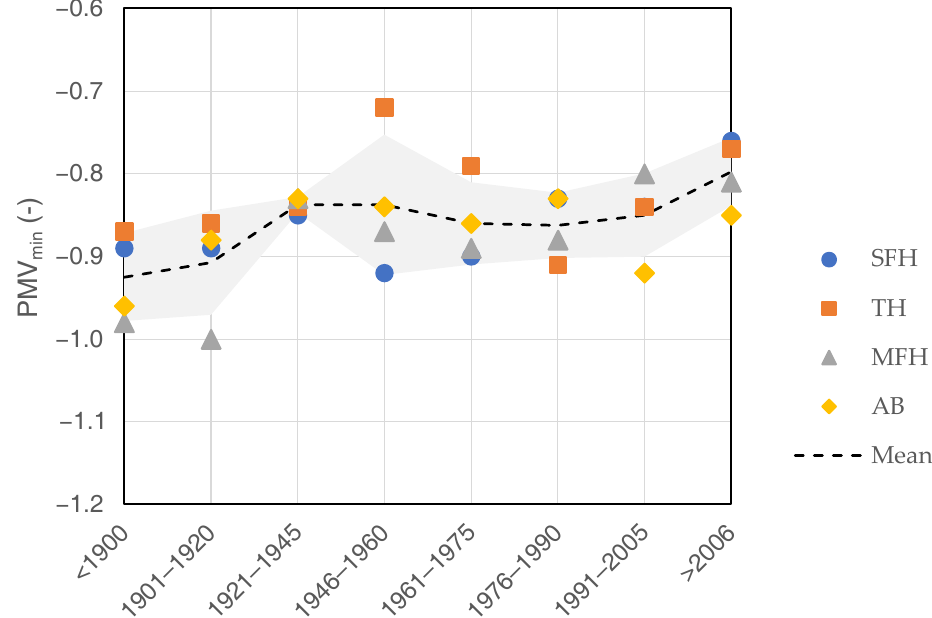
Figure 6. Minimum predicted mean vote (PMV) recorded in the heating season for the different types of buildings as a function of construction period. Gray area: standard deviation of the PMVs for the different building types.